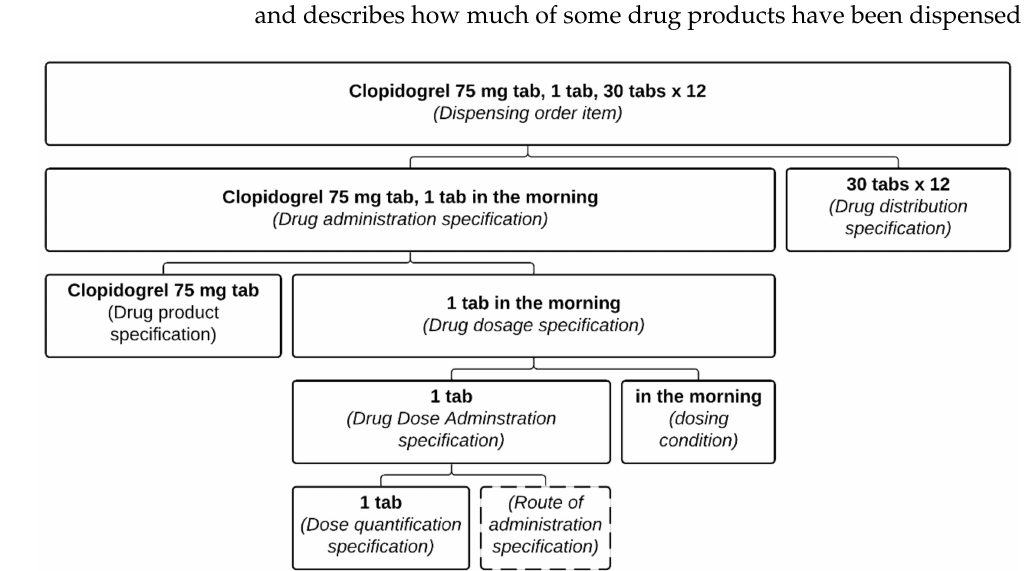
Figure 2. Representation of pharmacist dispensing order item. This is the result of the processing of the prescription from Figure 1. Each part of the pharmacist dispensing order item is associated with its relevant class.